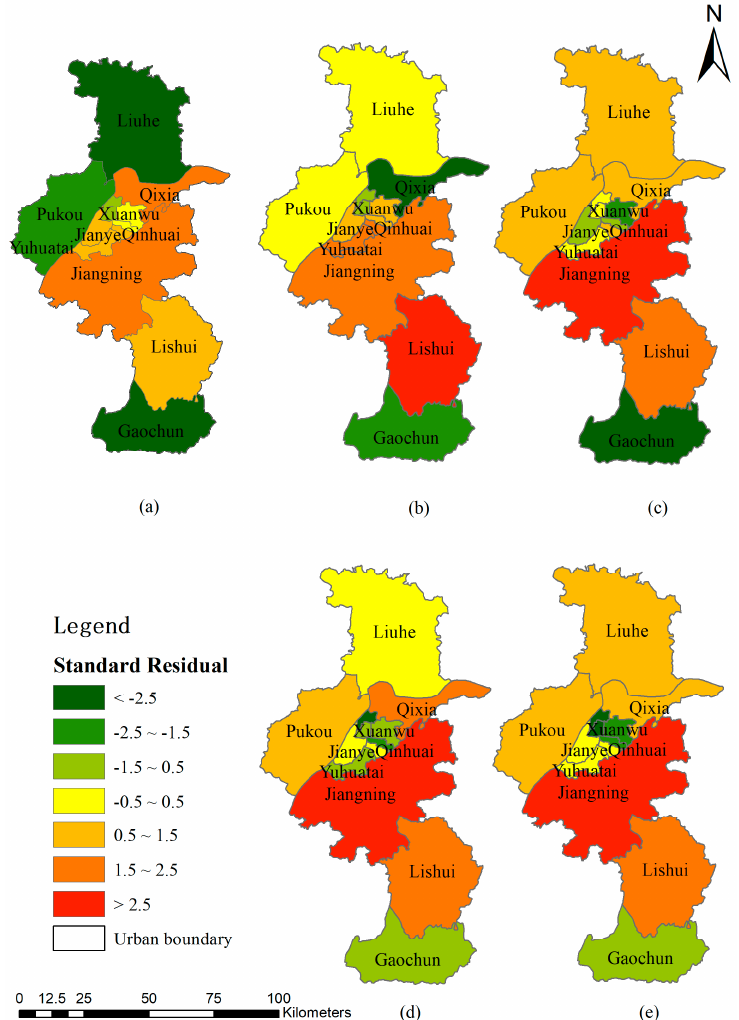
Figure 9. The standard residual map of the relationship between road network expansion and selected variables by geographically weighted regression. ( a ) The first industry; ( b ) The second industry; ( c ) The third industry; ( d ) PM2.5 index; ( e )